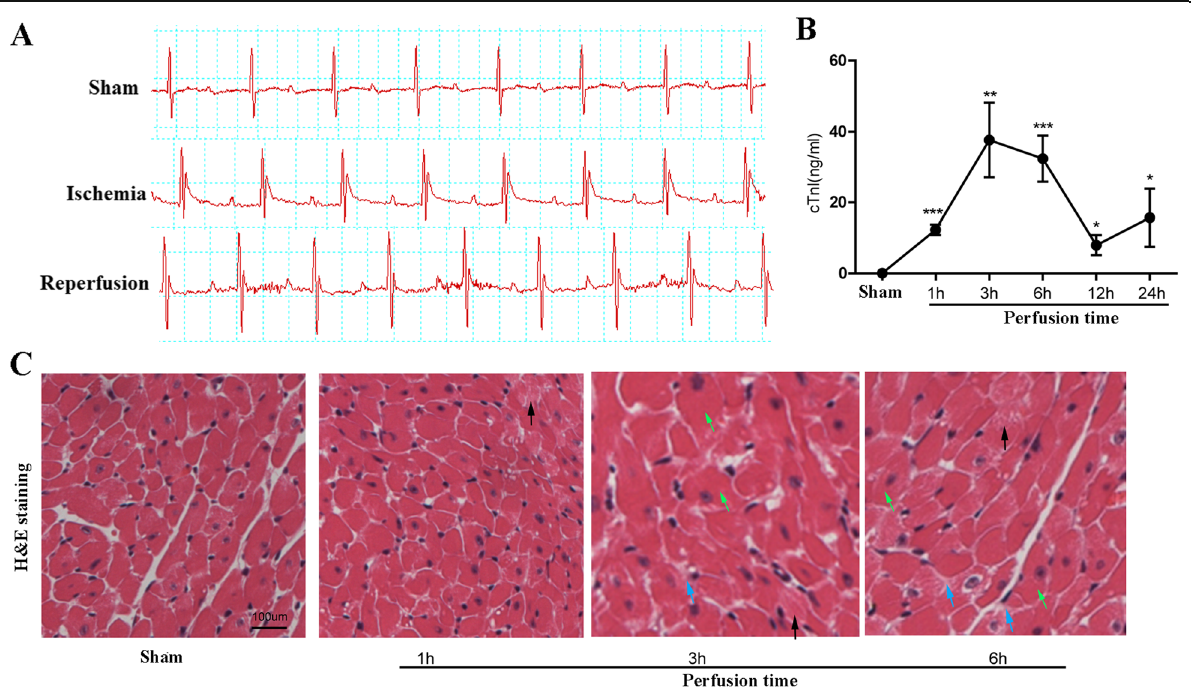
Fig. 1 Establishment of a murine model bearing cardiac ischemia/reperfusion (I/R) injury. a Electrocardiogram monitoring of mice with (ischemia group) or without (Sham group) coronary artery occlusion. Mice after re-opening of the left anterior descending (LAD) artery (perfusion group) were also subject to ECG monitoring. b ELISA detection of serum cTnI levels in Sham group of mice and in mice with distinct perfusion time. c Hematoxylin & Eosin (HE) staining of heart tissues were performed. Myocardial cells in the sham group were well-ordered with regular structure, while myocardial cells from the I/R injured mice were swelling in the plasma (black arrow) and showed slight interstitial edema (blue arrow) or occasional cell hypertrophy (green arrow) after 3 or 6 h ’ reperfusion. *, p < 0.05 vs.